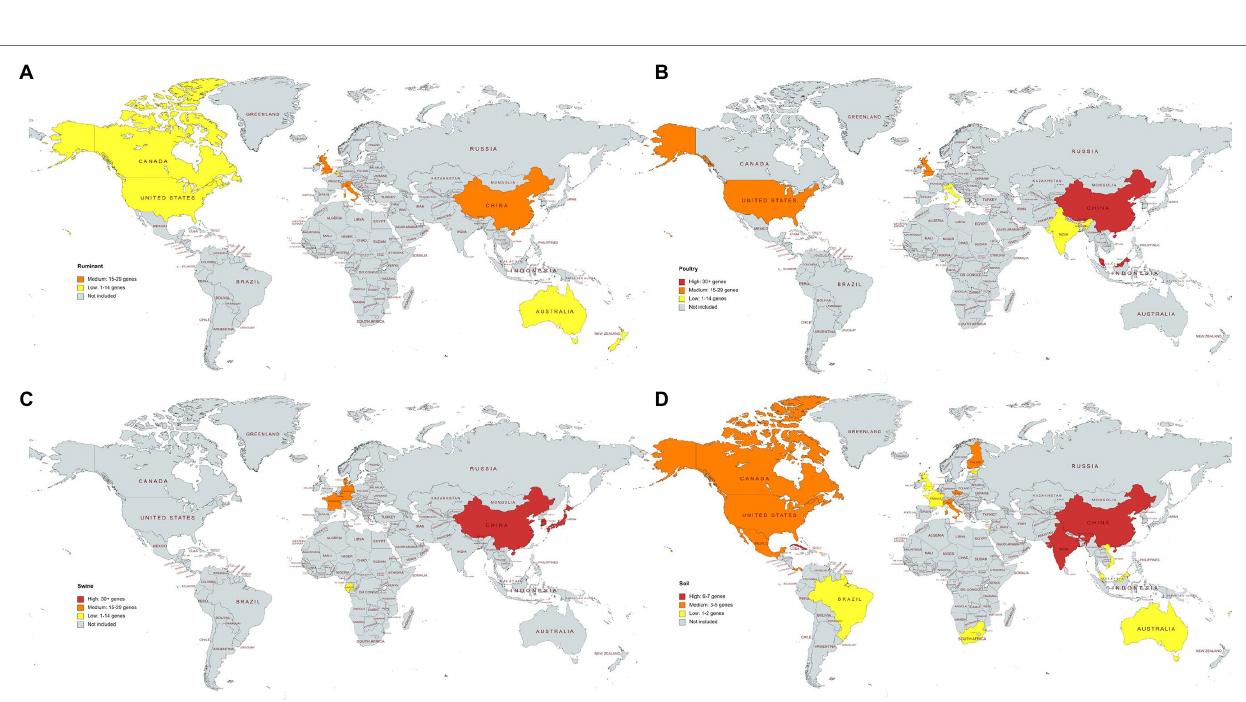
FIGURE 6 | (A–D) The average number of different antimicrobial resistance genes per country and microbiome. Data for countries represented by one sample are not shown. (A) Ruminant, (B) poultry, (C) swine, (D) soil. (A–C) High: 30+ genes, medium: 15–29 genes, low: 1–14 genes. (D) Soil samples. High: 6–7 genes, medium: 3–5 genes, low: 1–2 genes. Soils samples from Antarctica are not included, and they showed medium average resistance (average of three distinct resistance genes per sample).